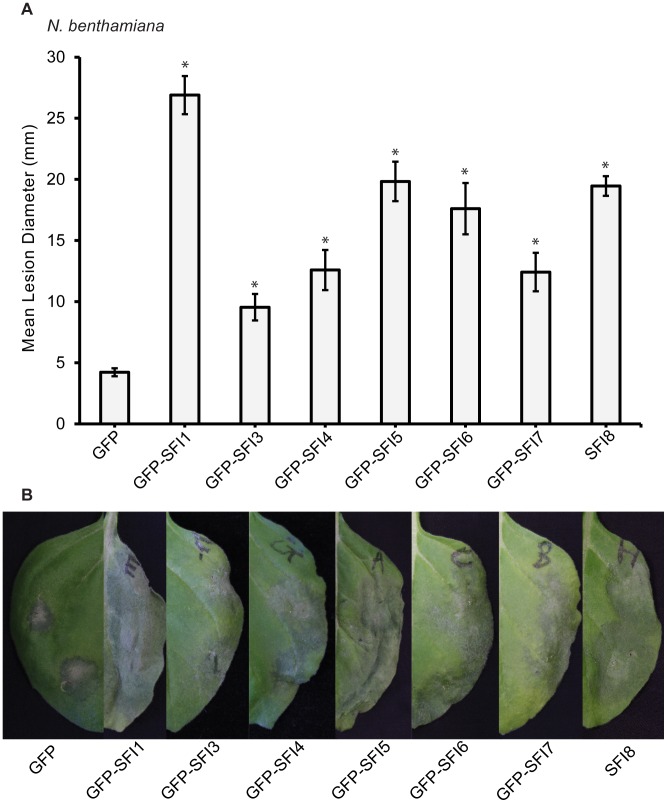
Effect of transient expression of SFI effectors enhances P. infestans colonization of N. benthamiana.Mean lesion diameter (A) and typical disease development symptoms (B) are shown for P. infestans 7 days post-inoculation over sites on leaves where an effector construct or empty vector was agro-infiltrated 1 day earlier. Each effector was expressed as an N-terminal GFP fusion protein as indicated, except for SFI8. Error bars represent SEM, and significant difference (* = p<0.001) in lesion size compared to empty vector control was determined by one-way ANOVA. Three biological replicates were performed, each using 24 inoculation sites per construct.